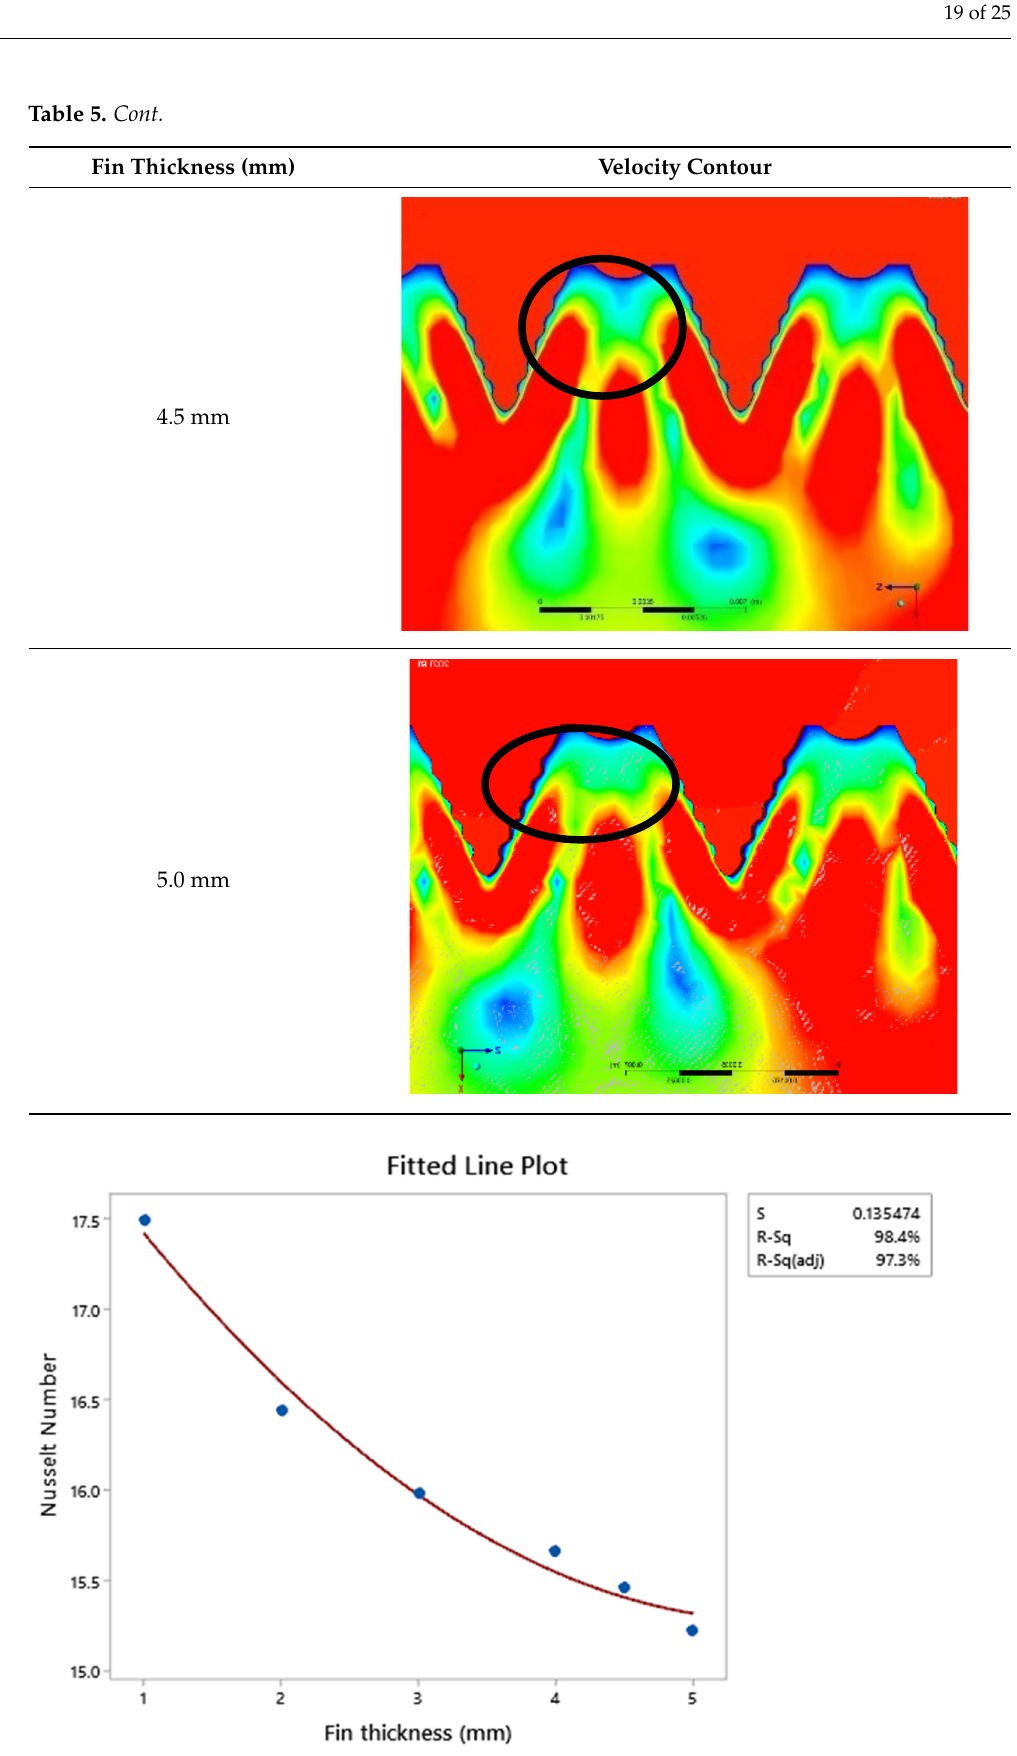
Figure 18. Comparison between Nusselt number from regression EQT vs simulation results. 3.2. Analysis of Coated Sn-Plated Copper Substrate The coated Sn-plated copper substrates were analyzed under different tests. Figure 19 shows the coating thickness on the selected substrates. Ultrasonic agitation and mag- netic stirring produced a sample with the required thickness, and no exposed copper was observed. The gas agitation method achieved the required coating for Sn-plated Cu sub- strate sample when the same parameter was applied for 10 nm and 100 nm AgNP-Sn plating. However, the coating could not meet the thickness specification. This situation is attributed to the current decreasing during the gas agitation electroplating, thereby inter- rupting the ion charge movement in the plating bath. The presence of Argentum (Ag) on the Sn-plated copper substrate demonstrated that nanoparticles of AgNP were successfully coated on the substrate surface. Table 6 summa- rizes the Ag wt% and average resistance for the coating experiments with different